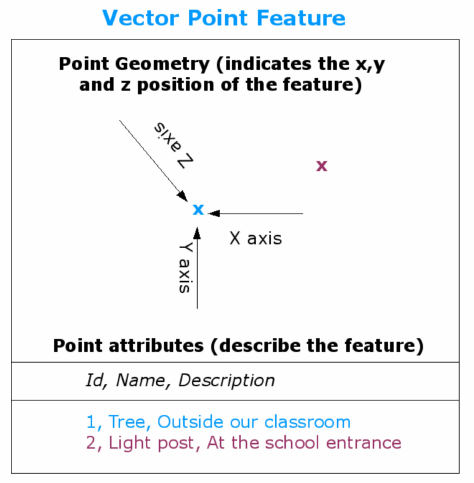
Figure 1. Point-type vector geometry.